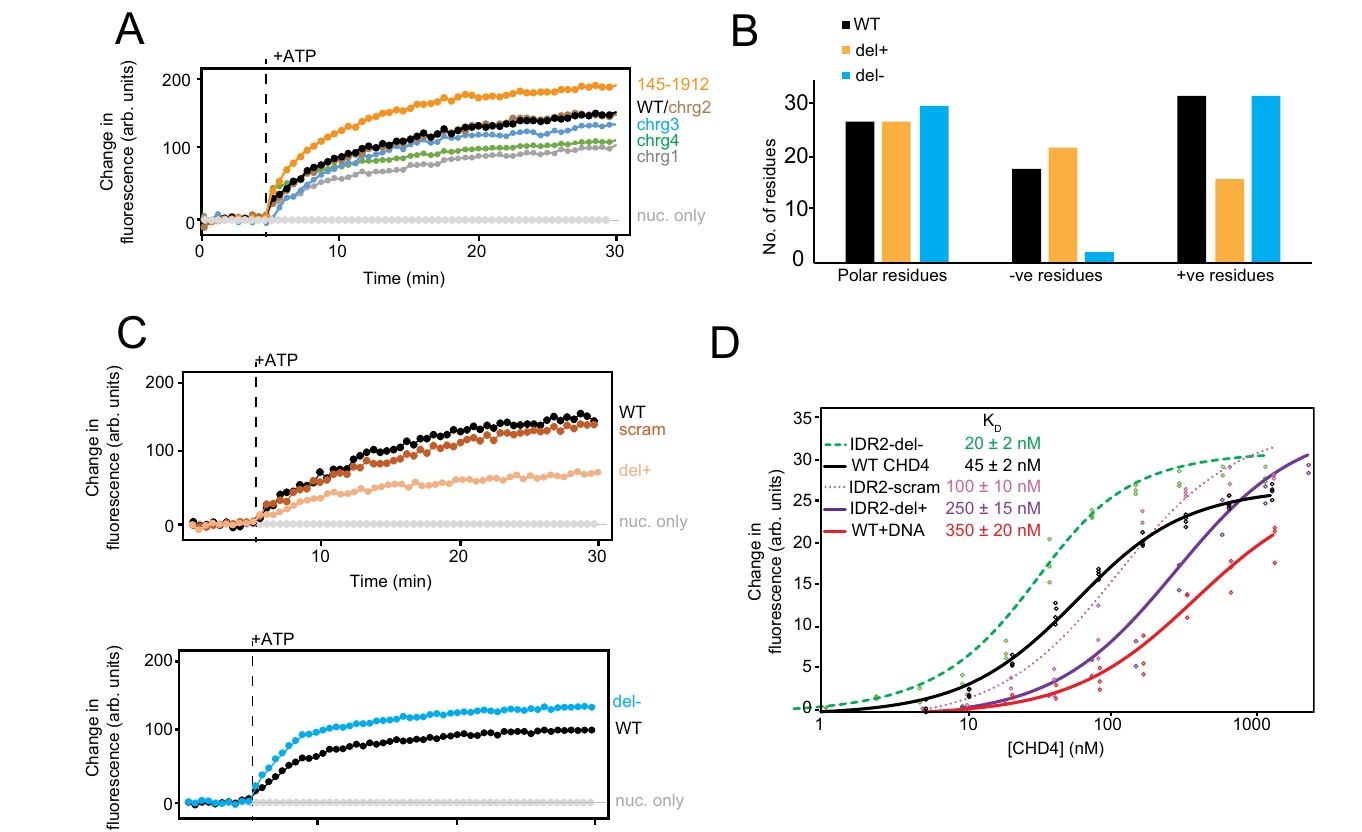
a mean of three replicates) displays an apparent biphasic shape, but this has not beeninvestigatedfurtheratthispoint.Itisonlyoneofthethreereplicatesthathas this shape. D Microscale thermophoresis (MST) data showing the binding of a 46w60 nucleosome to WT CHD4 and the indicated variants. Three technical replicatesand fi tstoa1:1bindingisothermareshownforeachmutantandK D values areindicated(seealsoSupplementaryFig.S1).WeestimatetheuncertaintyforK D ’ s to be ~25%. All raw data are provided as a Source Data fi